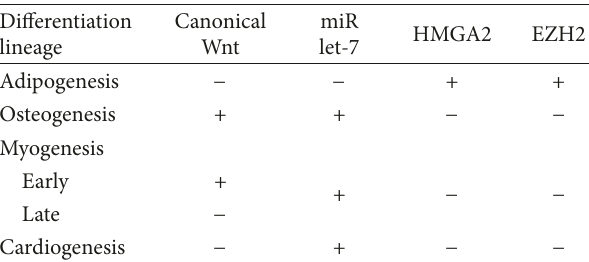
Table 1: Wnt/ 𝛽 -catenin, miR-let-7, HMGA2, and EZH2 action in mesenchymal stem cells (MSCs)